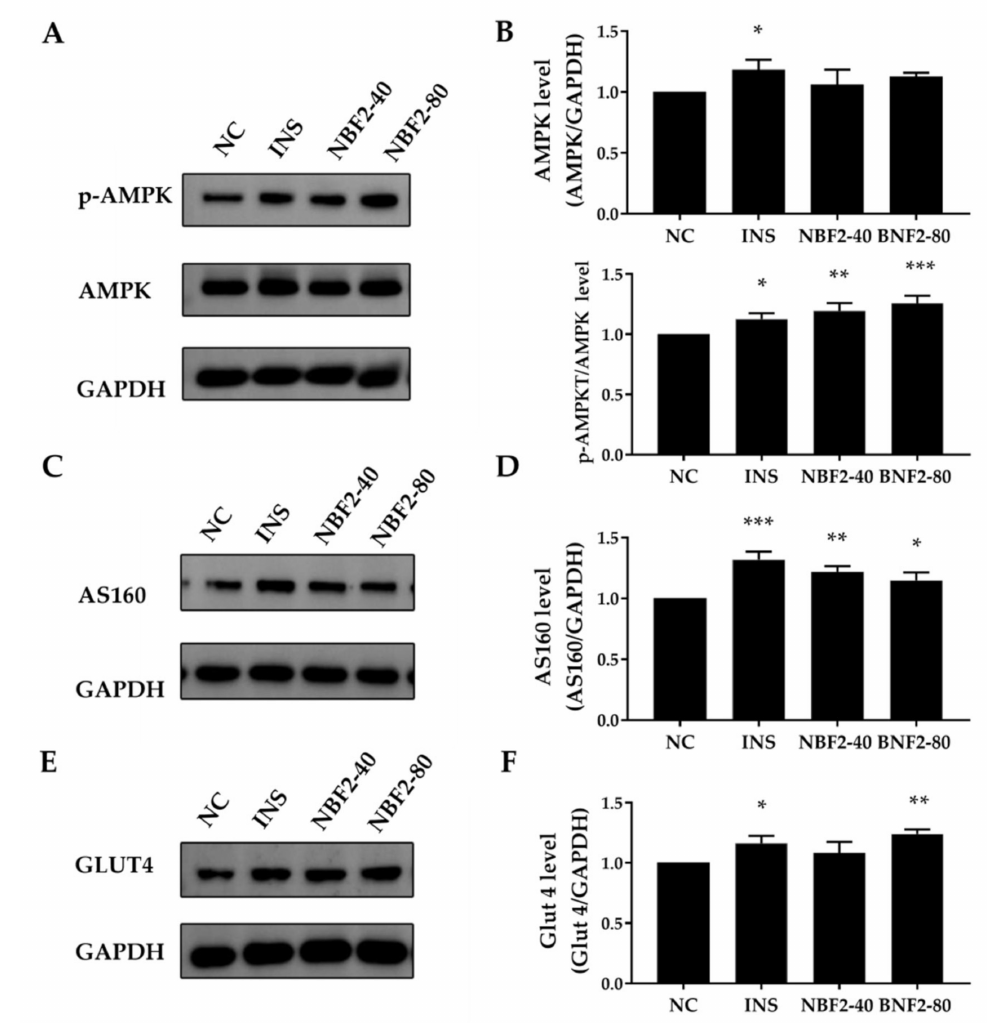
Figure 5. The effects of NBF2 supplementation on p-AMPK α (Thr172), AMPK α , AS160, and GLUT4 protein expression in 3T3-L1 adipocytes. ( A ) p-AMPK α (Thr172) and AMPK α protein expres- sion, ( B ) expression levels of AMPK α /GAPDH and p-AMPK α /AMPK α , ( C ) AS160 protein ex- pression, ( D ) expression level of AS160/GAPDH, ( E ) GLUT4 protein expression, ( F ) expression level of GLUT4/GAPDH. NC: negative control; INS: 250 ng/mL insulin (positive control); NBF2- 40: 40 µ g/mL NBF2; NBF2-80: 80 µ g/mL NBF2. Data are presented as mean ± SD ( n = 3). * p < 0.05, ** p < 0.01, *** p < 0.001 versus negative